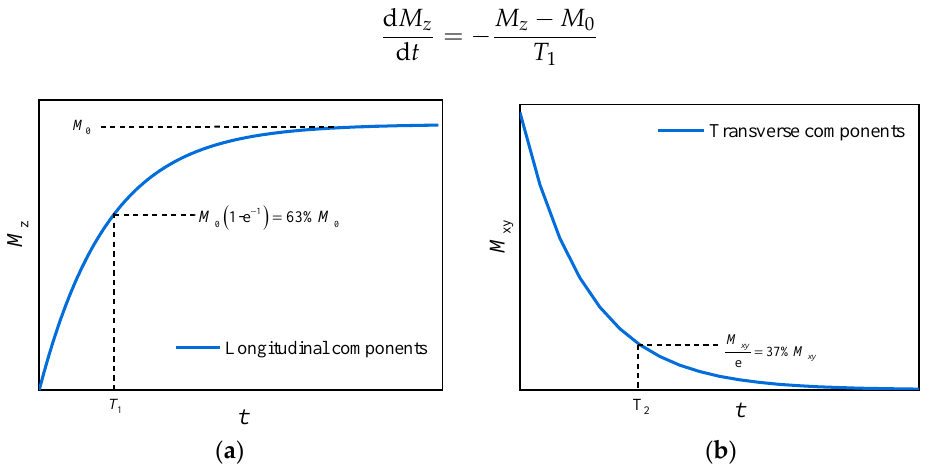
Figure 5. Schematic diagram of the changes in the longitudinal and transverse components in the relaxation process: ( a ) Longitudinal components; ( b ) Transverse components.